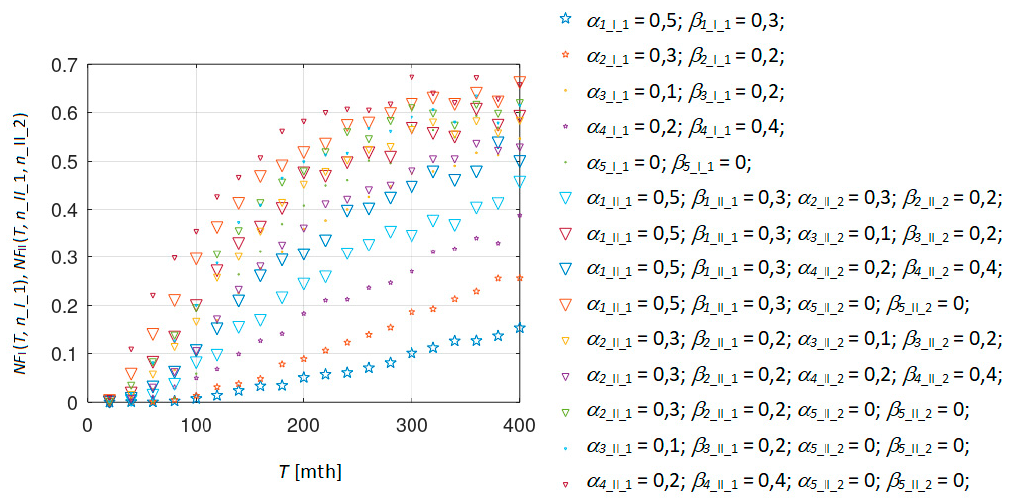
Figure 5. The expected cost per unit time for all the tested combinations of the two-stage policy for the range of inspection interval T limited with respect to the most economical solutions.